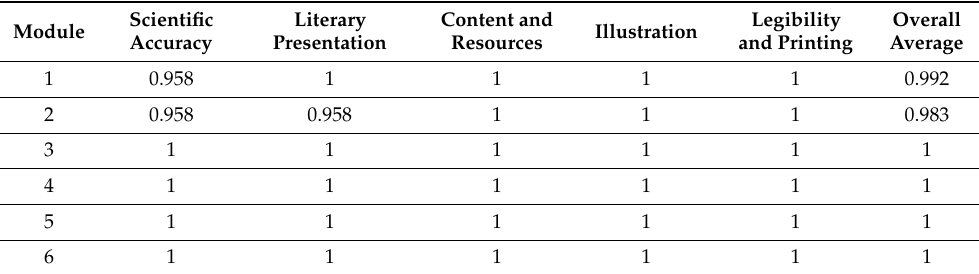
Table 4. The CVI of each module as per the content experts’ opinions ( n =